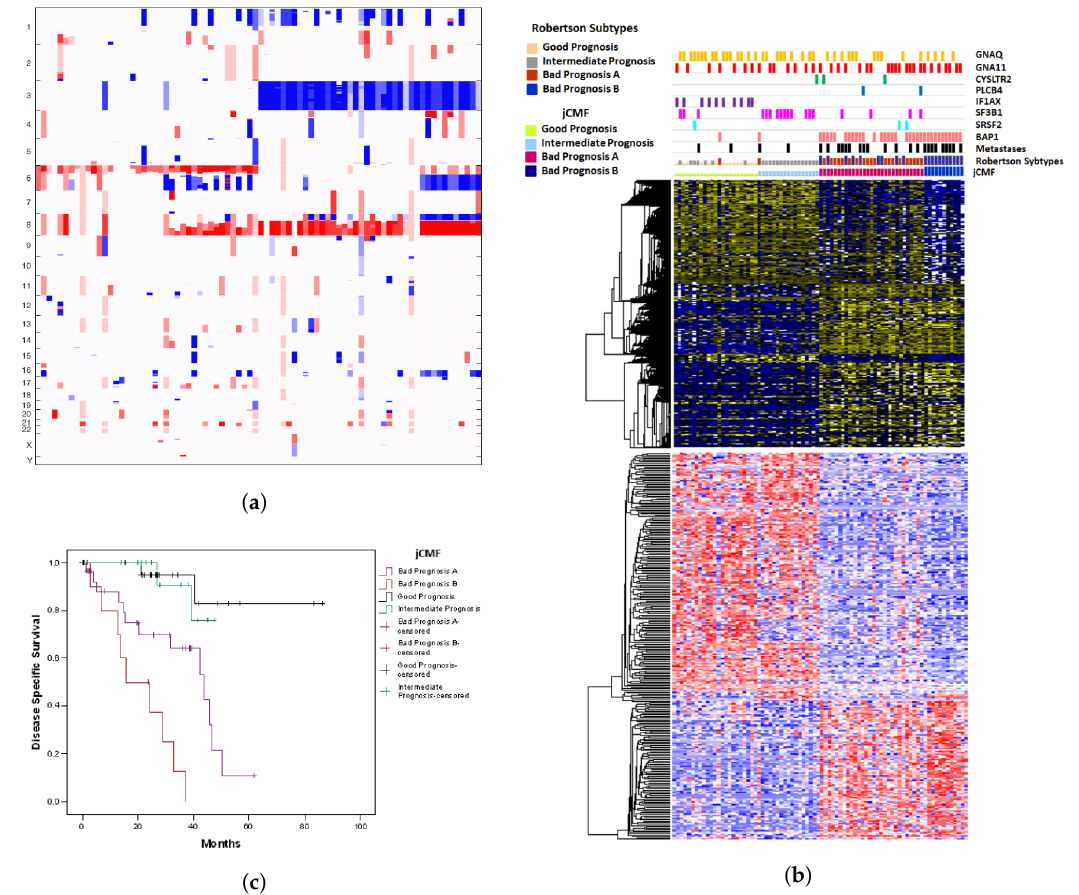
Figure 2. ( a ) Copy Number variation plot for the clusterings obtained by jCMF; columns = samples, rows = chromosomes. ( b ) Somatic mutation, transcriptome and methylome data for the clusterings obtained by jCMF; columns = samples, rows = genes. ( c ) Kaplan Meyer survival curves for the clusterings obtained by jCMF; y -axis = ratio of patients surviving, x -axis: time in